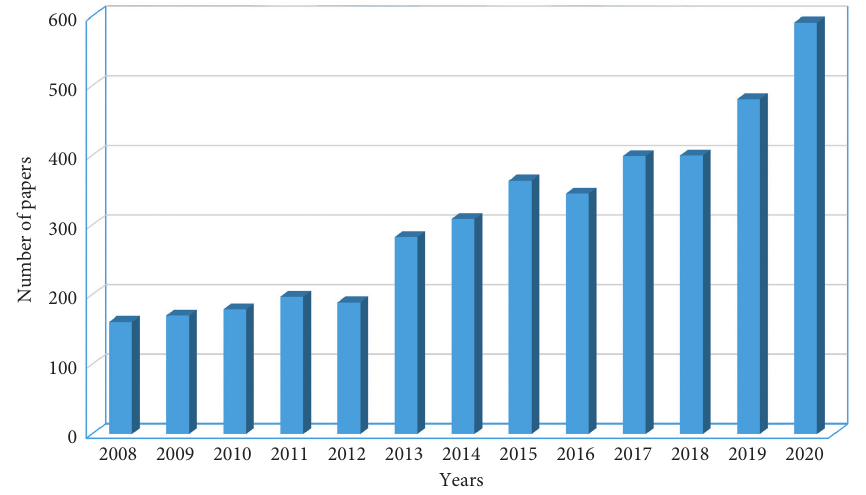
Figure 1: Papers published in the mentioned